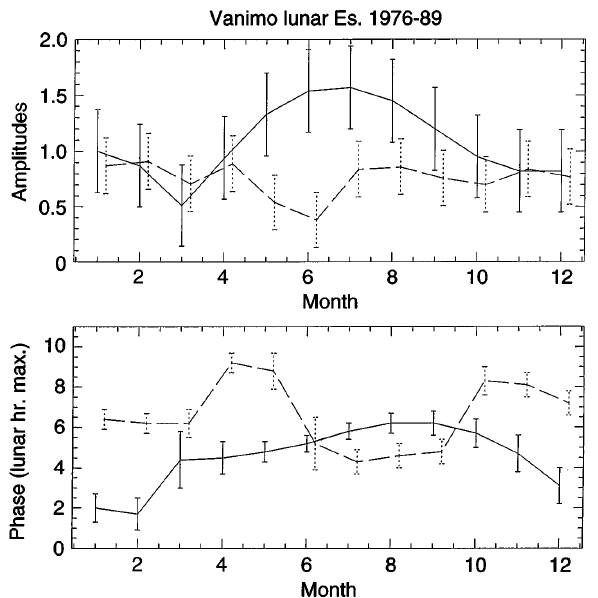
Fig. 6. Variation of amplitude and phase with season of the lunar tide in Es at Maui. Data are from 1976 to 1987. The solid line is for h ¢ Es and the dashed line for f oEs. The h ¢ Es amplitudes are in km and the f oEs amplitudes in 0.1 MHz.The f oEs points are slightly o(cid:128)set along the time axis so the error bars ((cid:139)one standard deviation) do not overlap